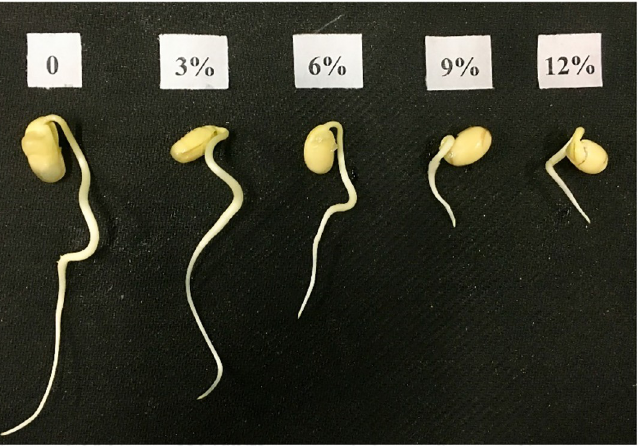
Fig 1. Germination of seeds with different concentrations of PEG. 0: deionized water, no water stress; 3%, 6%, 9% and 12% were indicated 3%, 6%, 9% and 12% PEG6000 (w/v).